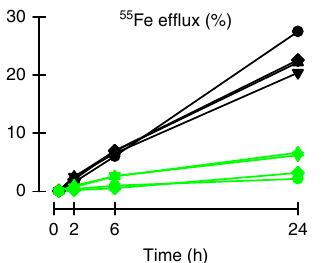
Fig. 4 Calcium activates Fpn-mediated iron ef fl ux in a HEK cell expression system. HEK293T cells expressing Fpn were loaded with 55 Fe, and 55 Fe ef fl ux measured in media containing 1 mM Ca 2 + (black) or 0 Ca 2 + + 1 mM EGTA (green). Data, normalized by 55 Fe content at time = 0, are displayed as induced minus uninduced in the same preparation. Each symbol-and-line plot represents one of four independent preparations. Two-way RM ANOVA: interaction of [Ca 2 + ] o and time ( P < 0.001); Ca 2 + signi fi cantly activated 55 Fe ef fl ux over 6 h ( P = 0.002) and 24 h ( P < 0.001), but not at earlier time points ( P ≥ 0.24)